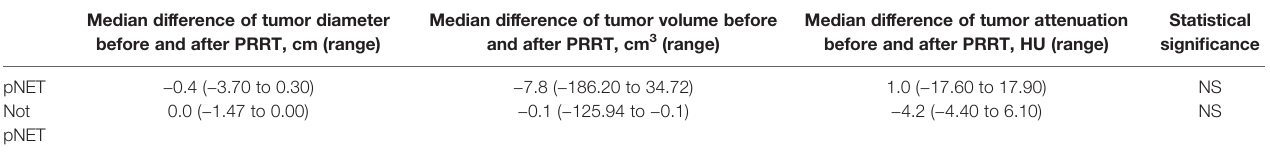
TABLE 2 | Changes in median (range) of diameter, volume, and attenuation of tumor before and after PRRT in pNET and not pNET patients. Median difference of tumor attenuation Median difference of tumor diameter Median difference of tumor volume before before and after PRRT, HU (range) before and after PRRT, cm (range) and after PRRT, cm 3 (range)